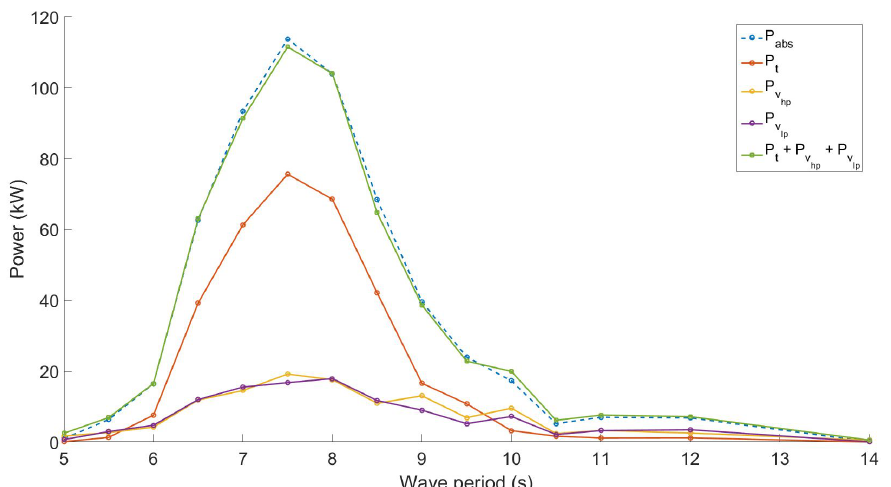
Figure 16. Average absorbed power from the waves and dissipated powers across valves and orifice (full-scale